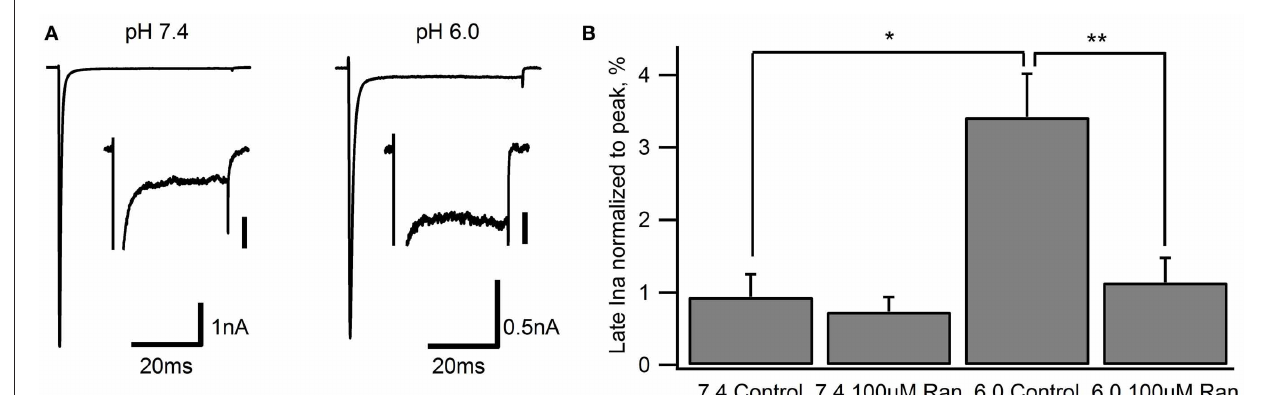
current in drug-free conditions (pH 7.4: 0 . 94 ± 0 . 34%, n = 7; pH 6.0: 3 . 4 ± 0 . 6%, n = 7) and with 100 μ M ranolazine (pH 7.4: 0 . 73 ± 0 . 17%,